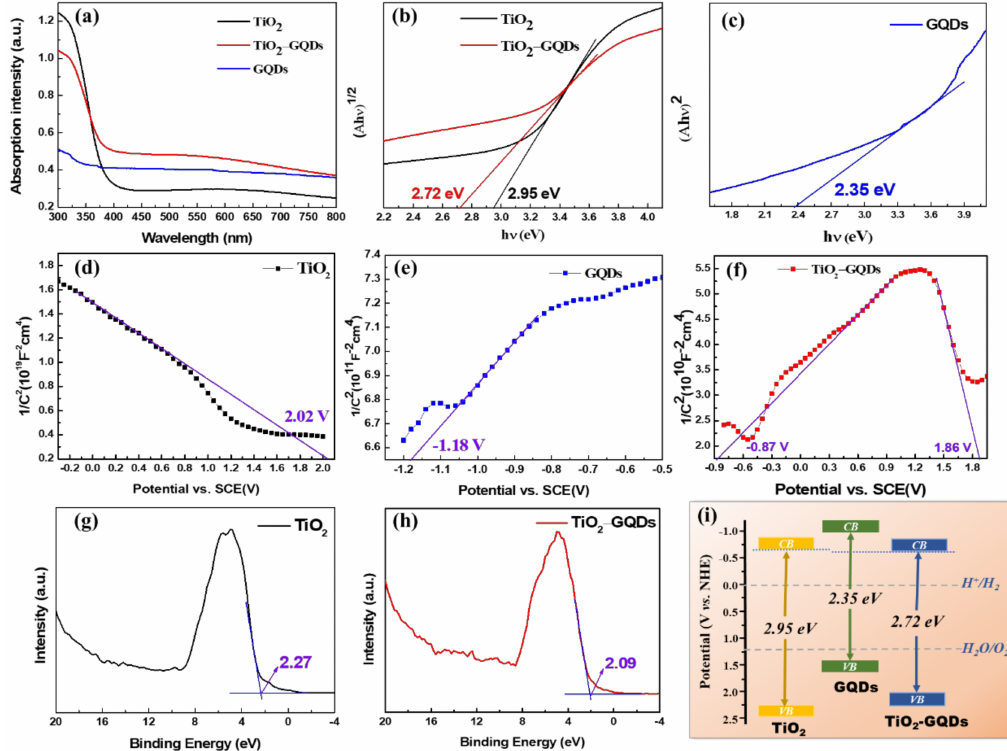
Figure 6. ( a ) UV-vis DRS. ( b ) The plots of (Ah ν ) 1/2 versus h ν of TiO 2 caterpillar and TiO 2 -GQDs hybrid samples and ( c ) the plots of (Ah ν ) 2 versus h ν of GQDs. ( d ) M–S curves collected on TiO 2 caterpillar, ( e ) GQDs and ( f ) TiO 2 -GQDs caterpillar hybrid. ( g ) VB XPS spectra of TiO 2 caterpillar and ( h ) TiO 2 -GQDs hybrid. ( i ) Band structure diagram of GQDs, TiO 2 caterpillar and TiO 2 -GQDs caterpillar